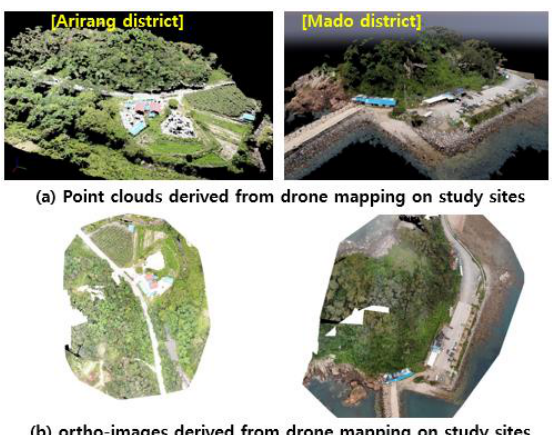
Figure 6. Drone mapping